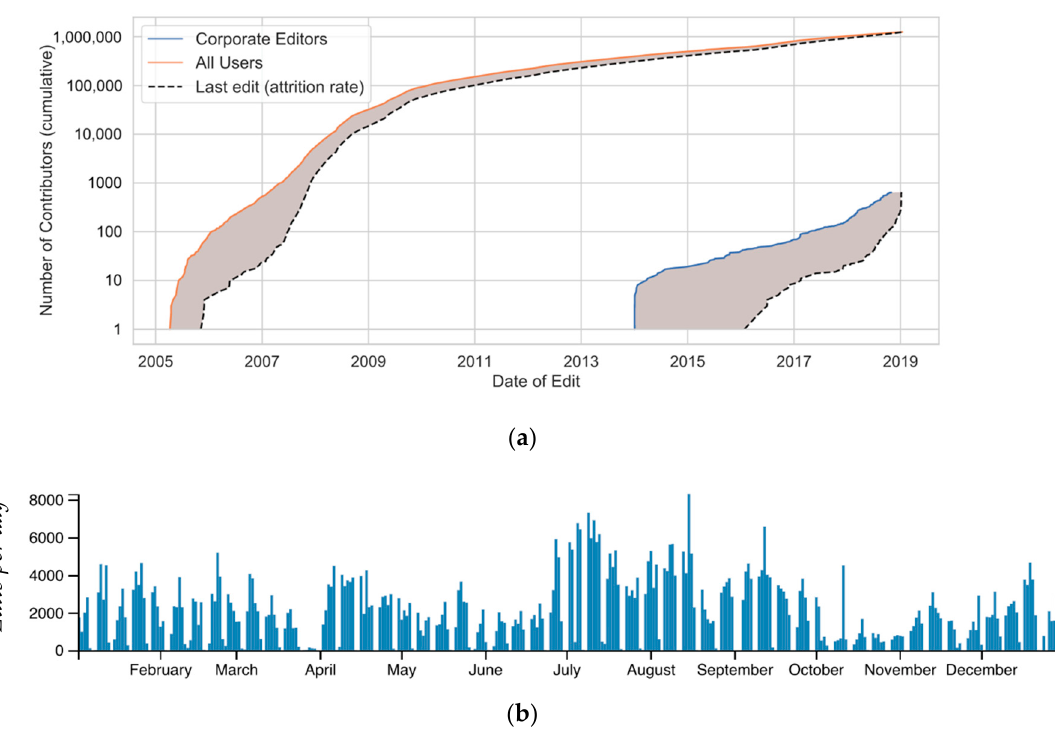
Figure 5. Characteristics of Corporate editors: ( a ) The rate of growth of all OSM editors compared to corporate editors. The solid lines represent number of contributors denoted by the day of their first edit. The dotted lines represent the number of users denoted by the day of their last edit. The shaded area between the solid lines and the dotted lines could be thought of as the relative size of the “active” community. These two lines converge at the end because those are the most recent edits in our data. The steep slope in the corporate-editors dotted line shows that these editors have been active recently (not one-time contributors); ( b ) Edits per day by the Facebook team in 2018. Consistent activity throughout the year showing 52 weeks of relatively consistent work five days of the week, with no editing on weekends. This pattern of consistent weekday editing is present across all of the data teams we have